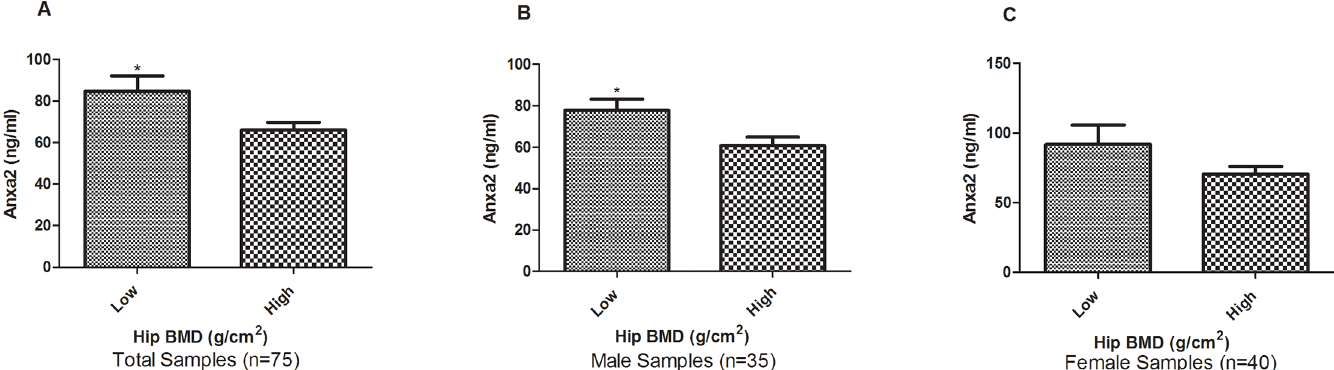
Fig 3. Up-regulation of plasma Anxa2 protein in low versus high BMD subjects. Presented are Anxa2 protein abundances in plasma in Sample 2. The data is described as mean±SD. (cid:3) : P < 0.05, as compared with high BMD subjects.